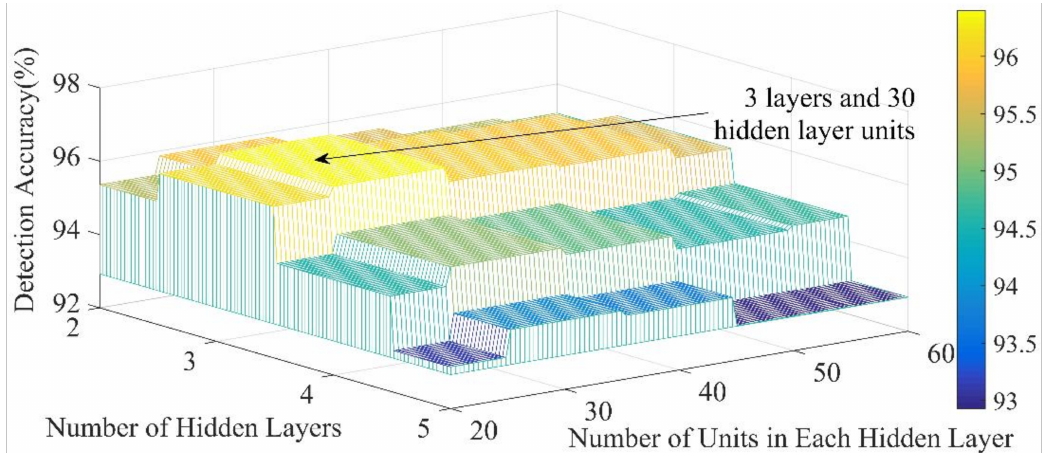
Figure 7. Accuracy of different hidden layers and different hidden layer